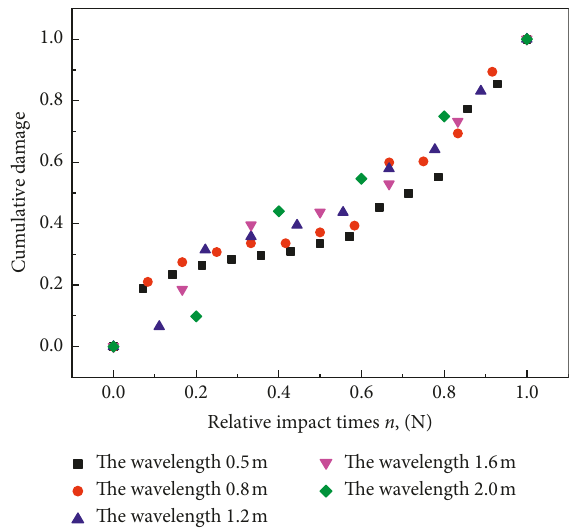
Figure 6: Damage evolution of siltstone under cyclical impact.